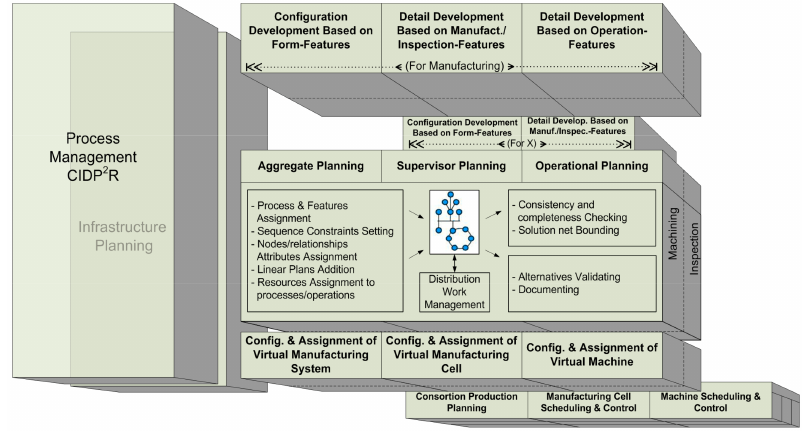
Figure 1. Functional architecture of the Collaborative and Integrated Development of Product, Process and Resource (CIDP 2 R) process